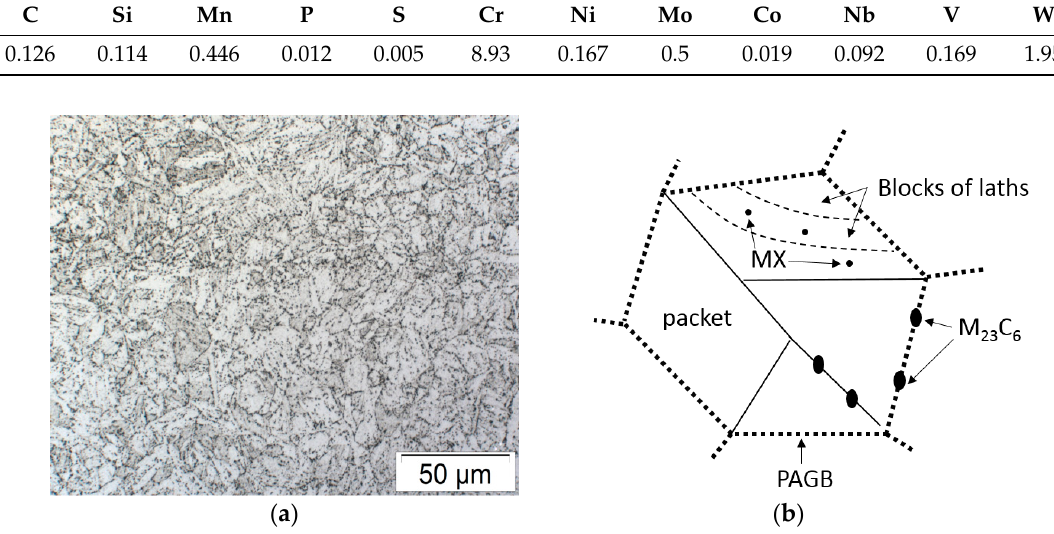
Figure 1. Microstructure of P92, ( a ) an optical micrograph and ( b ) schematic view of the internal